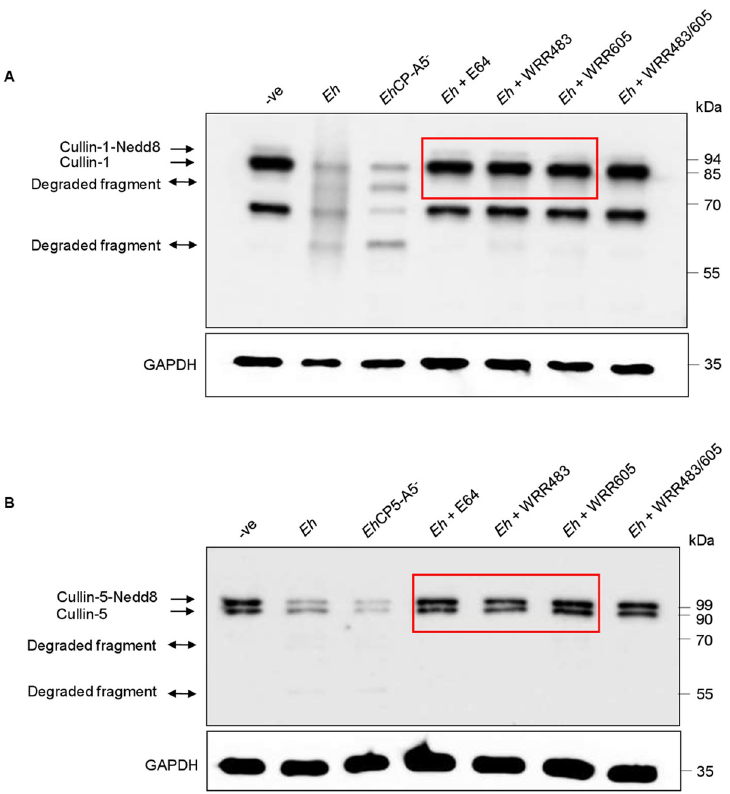
Fig 3. Cullin-1/5 degradation requires Eh CP-A1 and Eh CP-A4 but independent of Eh CP-A5. (A, B) THP-1 derived macrophages were incubated with wild type Eh (10:1 ratio), Eh CP-A5 deficient Eh ( Eh CP-A5 - ), E64 inhibitor- treated Eh , Eh pre-incubated with WRR483, (inhibitor for Eh CP-A1), WRR 605 (inhibitor for Eh CP-A4) or Eh pre- treated with both WRR483 and WRR605 in combination for 30 min at 37˚ C for 10 min. Post incubation, cells were washed and lysed and equal amount of protein was loaded onto SDS- PAGE gel and immunoblotted with anti-cullin-1 (A) , anti-cullin-5 (B) and anti-GAPDH antibody. Highlighted boxed areas on the figures show point of interest for cullin-1/5 as described in text. Results are representative of two independent